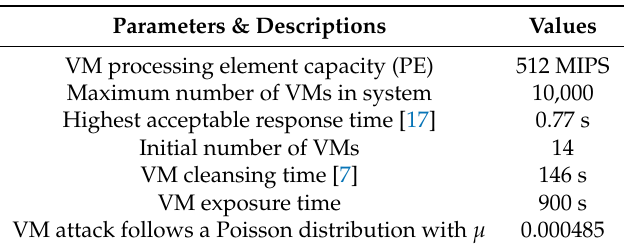
Table 1. Simulation environments. VM: virtual